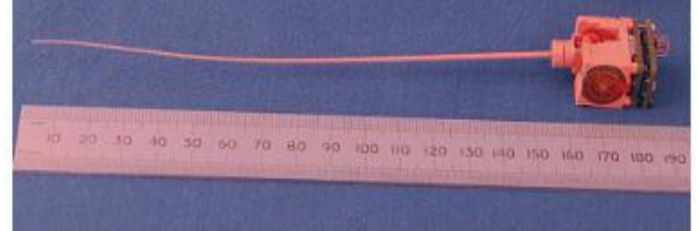
Figure 4. The largest utilized whisker